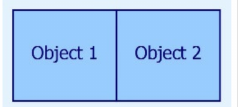
Figure 2. Multiplication of